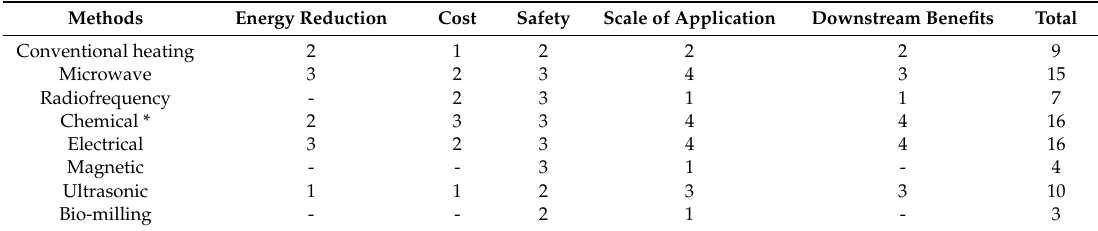
Table 10. Ranking of ore pretreatment methods (* cement production)